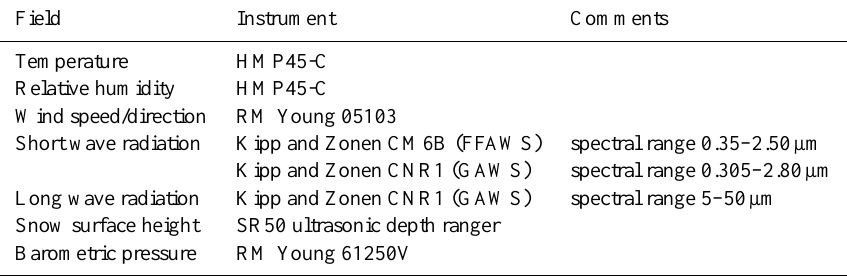
Table 1. Instrumentation at the glacier (G) and forefield (FF) AWS sites. Meteorological fields are measured each 10s, with 30min averages archived to the data loggers. Campbell Scientific data loggers are used at each site with a transition from CR10X to CR1000 loggers in summer 2007. Radiometers are both upward and downward